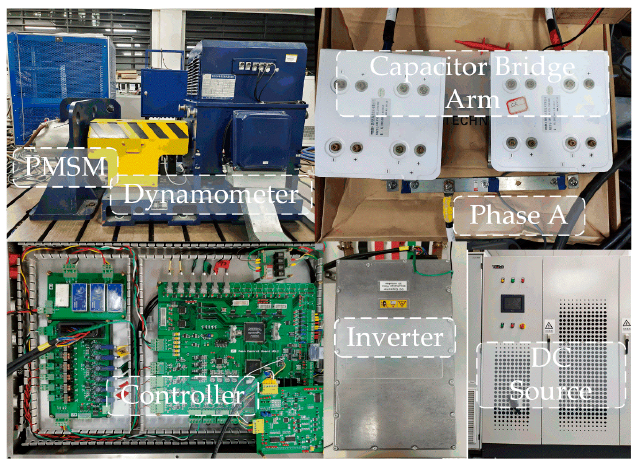
Figure 4. Experimental platform.